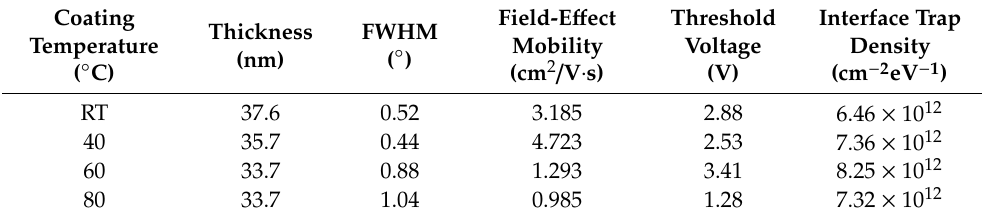
Table 1. The film and electrical characteristics of the DPP-SVS polymer-based TFTs with di ff erent blade-coating